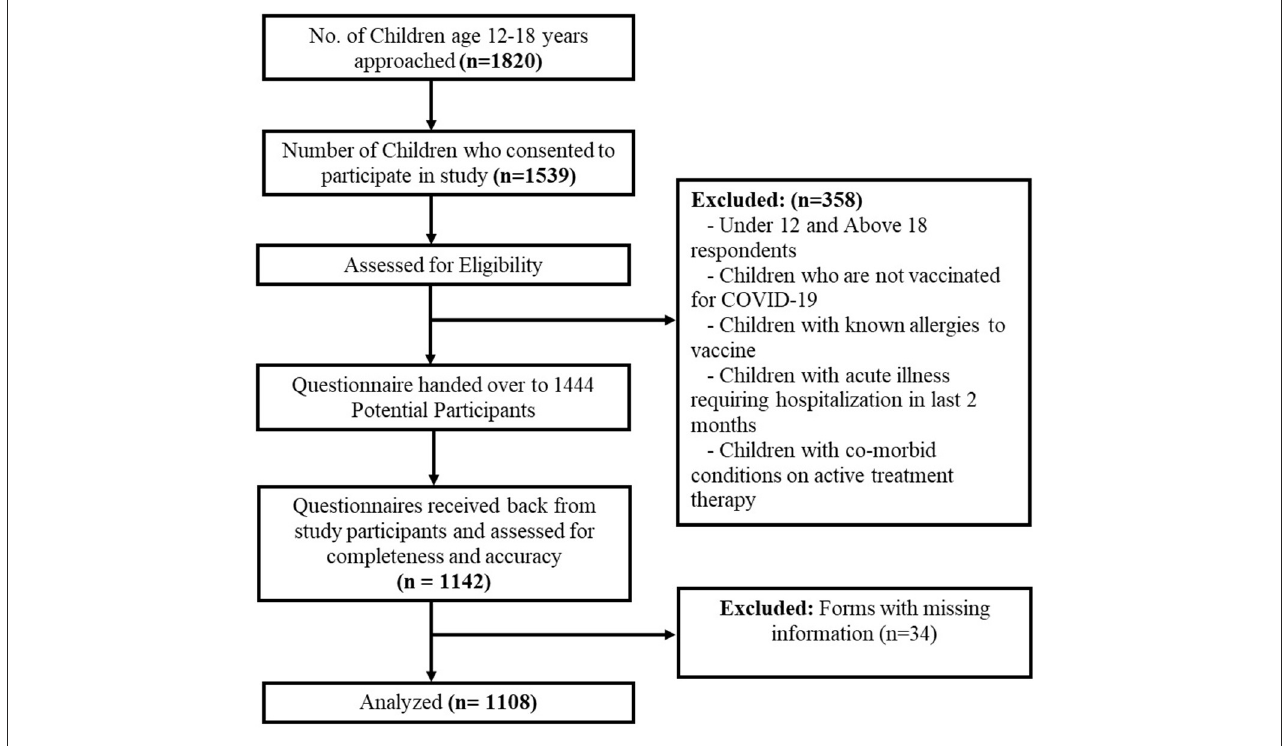
FIGURE1 Strobe flowchart of response rate of study participants.